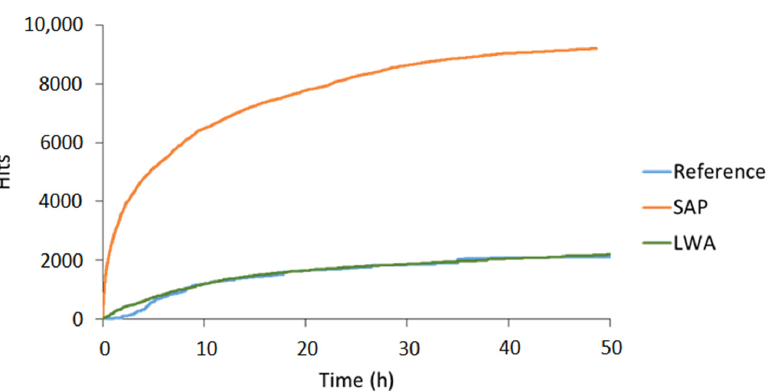
Figure 5. Cumulative hits vs. evaporation time of saturated reference, SAP and LWA cement